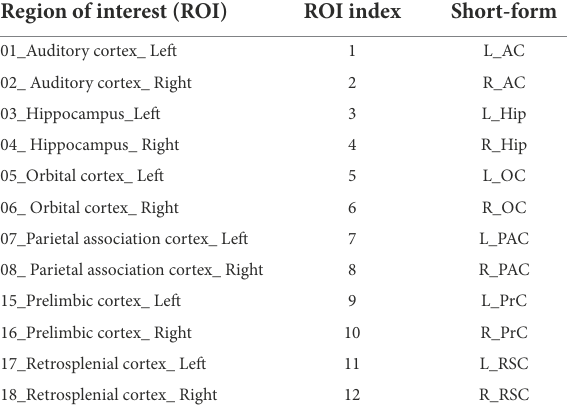
TABLE 2 Region of interest in aged rat